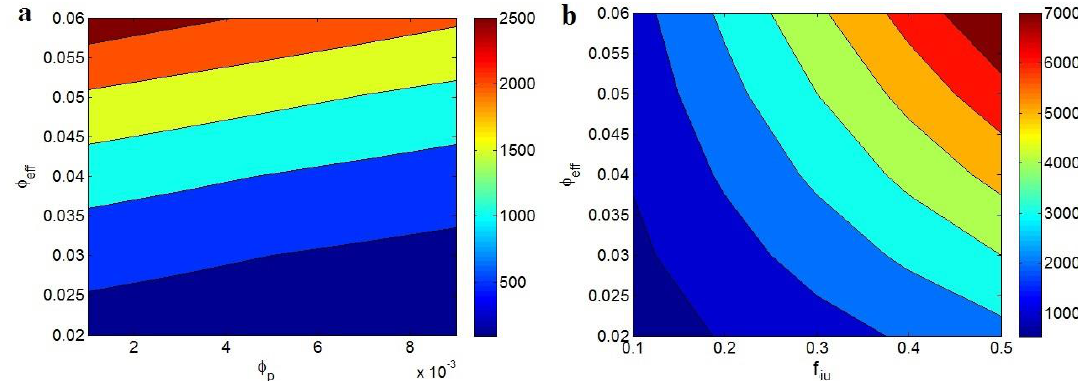
 ” and “  ” ” ef f p eff ” ranges ef f  ” ranges eff